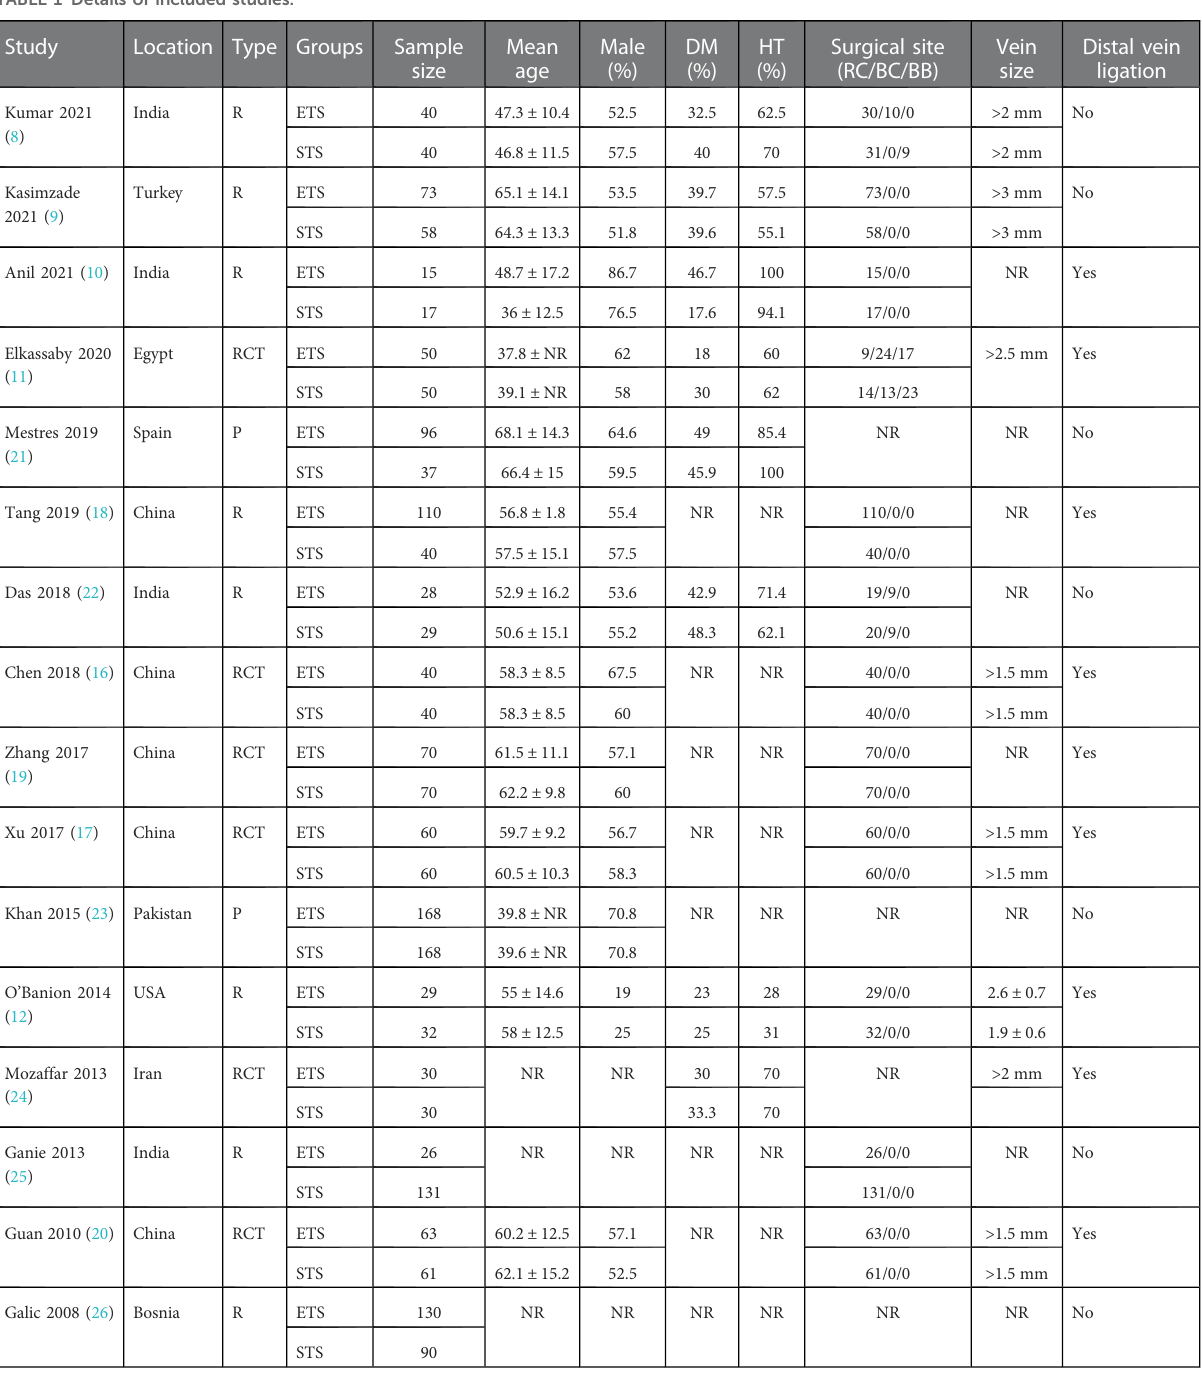
TABLE 1 Details of included